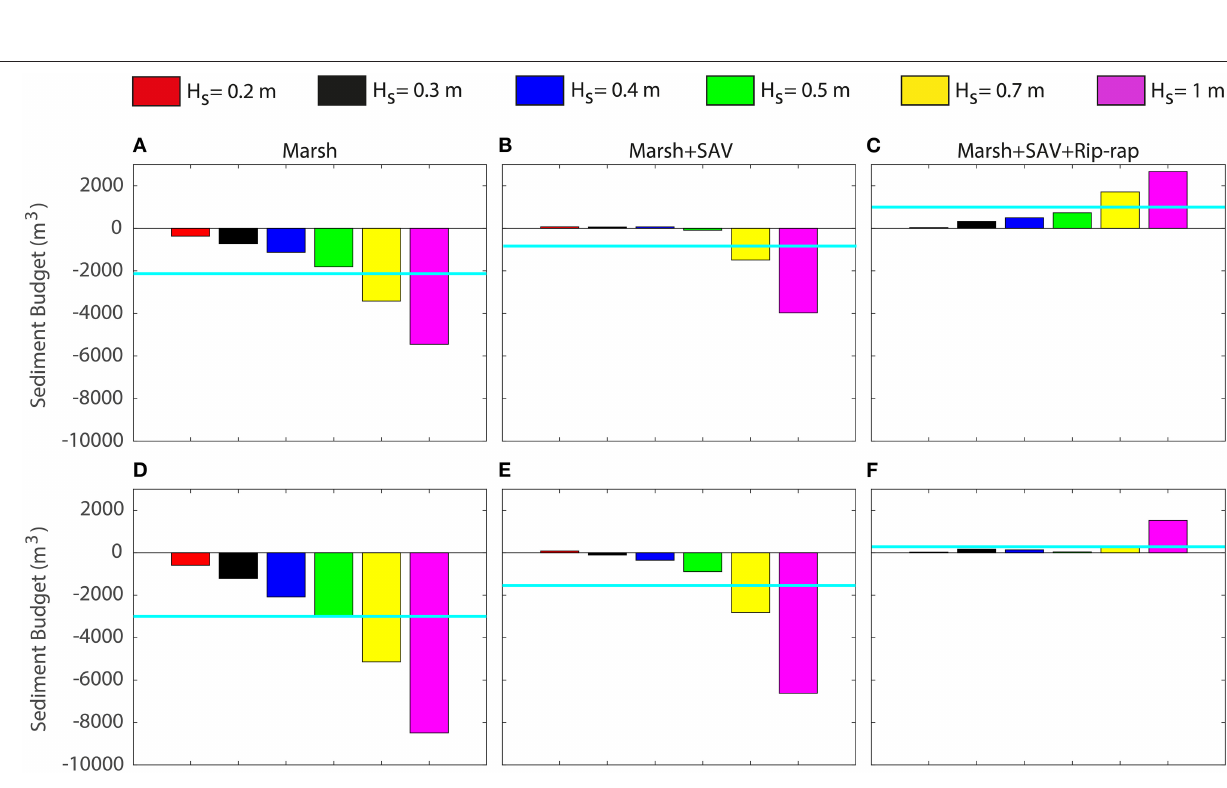
FIGURE 11 | Sediment balance between the various simulated scenarios averaged over the wave period. (A–C) show the sediment budget for the scenario with slope 0.8%, while (D–F) refer to slope 1%. Left column (A,D) refers to the case with the only marsh; mid column (B,E) to the case with marsh and SAV; right = = column (C,F) to the case with both vegetations and rip-rap. The light blue line denotes the mean